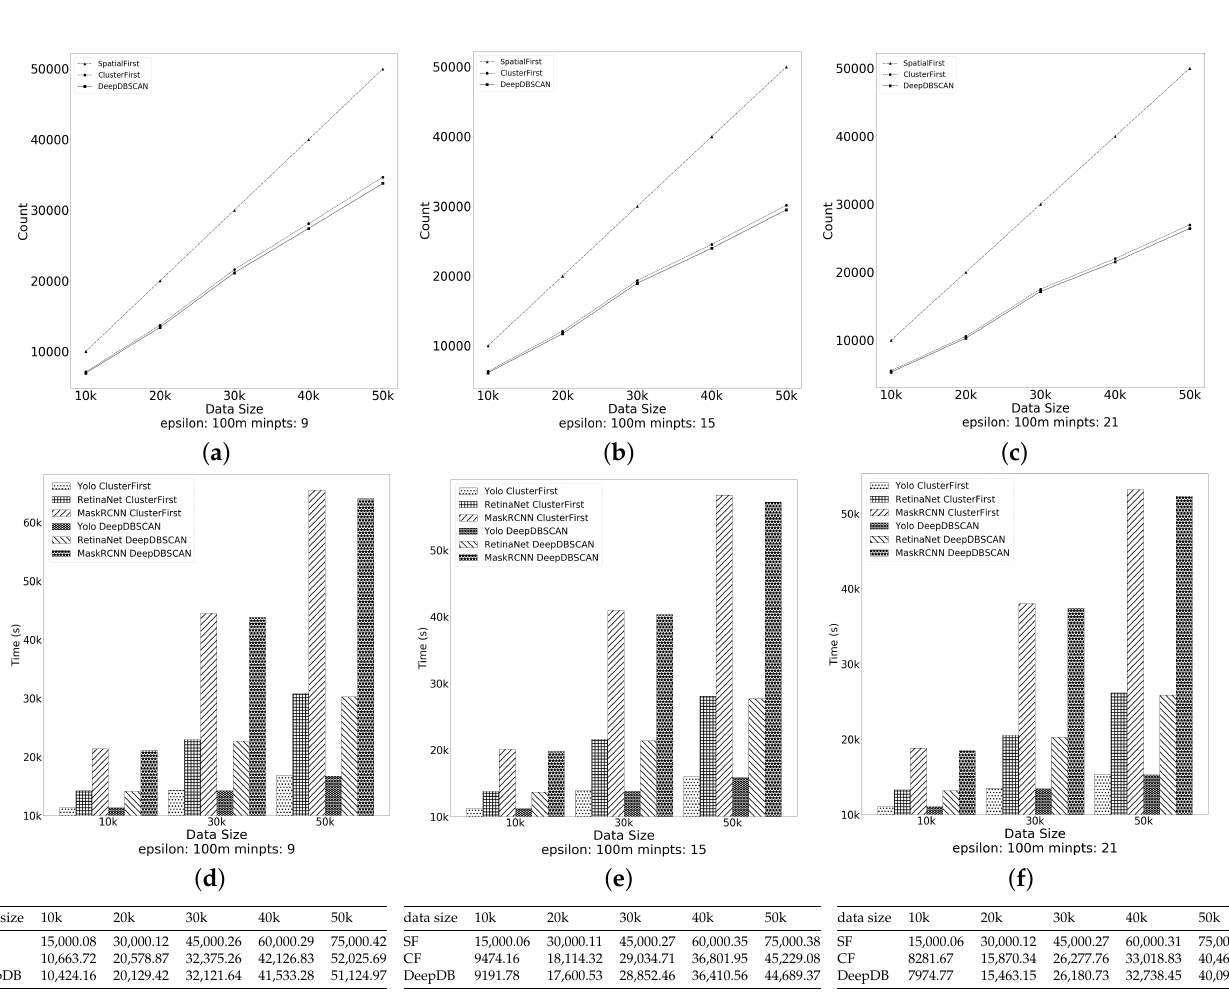
Figure 7. Effect of the data size. ( a – c ) number of object detections when minpts 9 to 21; ( d – f ) The time cost of each object detection model when minpts 9 to